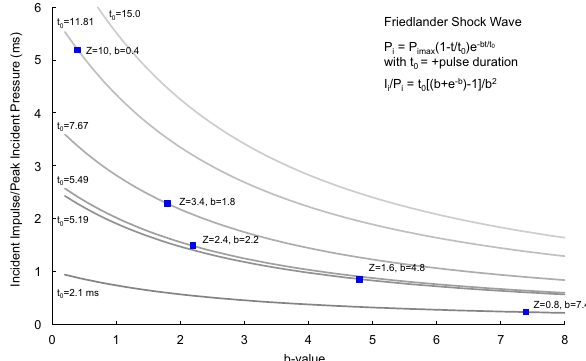
Figure 4. Friedlander shock wave b-value versus the + pulse duration (t 0 ).